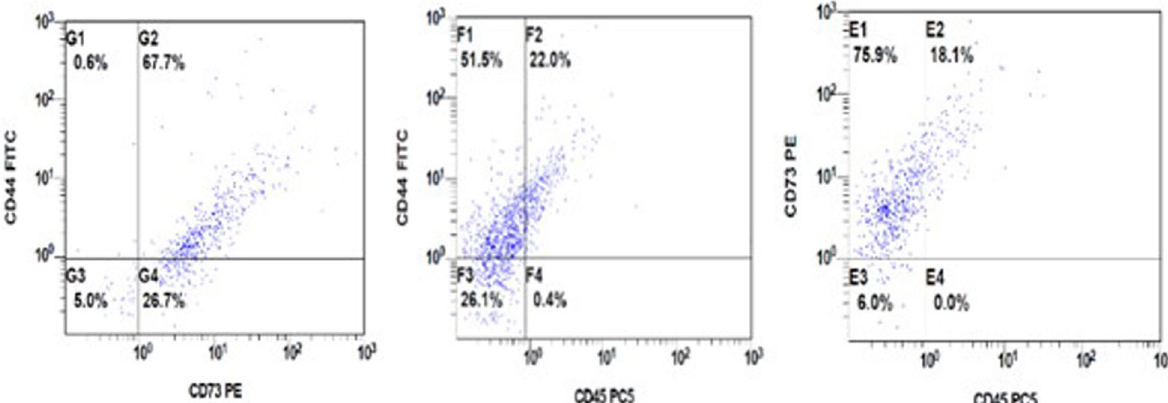
Fig. 4 A respective FCM dot-plot showing the gate protocol for HDPSCs. The HDPSCs were stained with stem cell markers (CD73, CD44, CD45). The CD73 and CD44 positive cells were gated cross-ponding to CD45